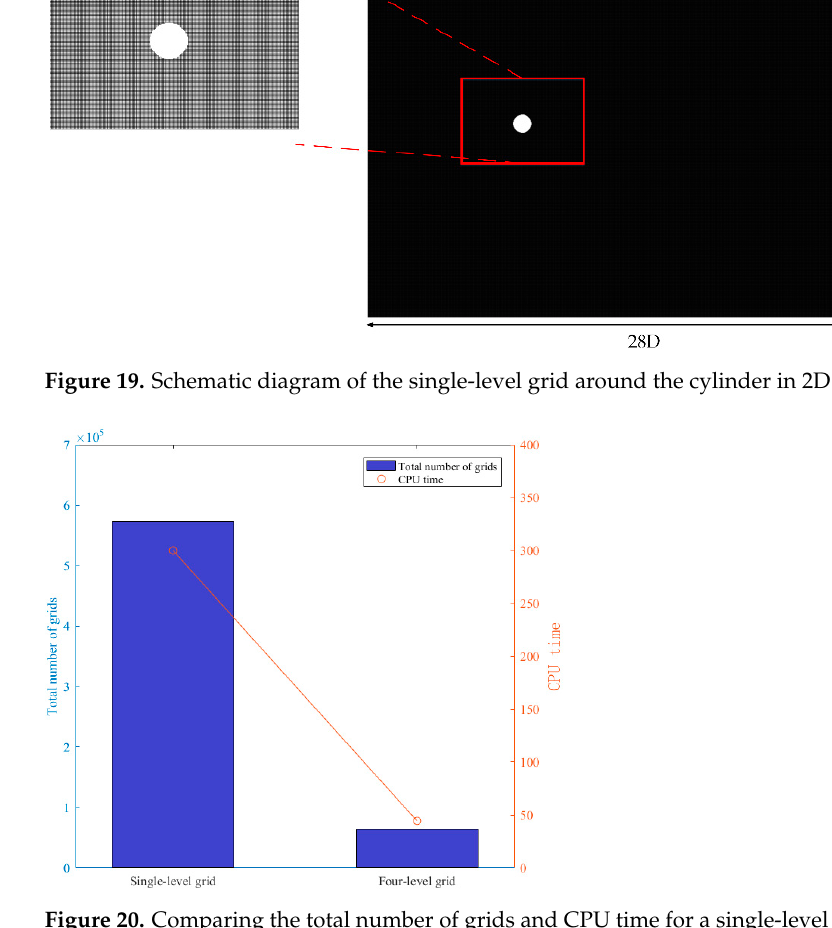
Figure 20. Comparing the total number of grids and CPU time for a single-level grid MRT-LBM and a four-level grid MRT-LBM at Re = 100.